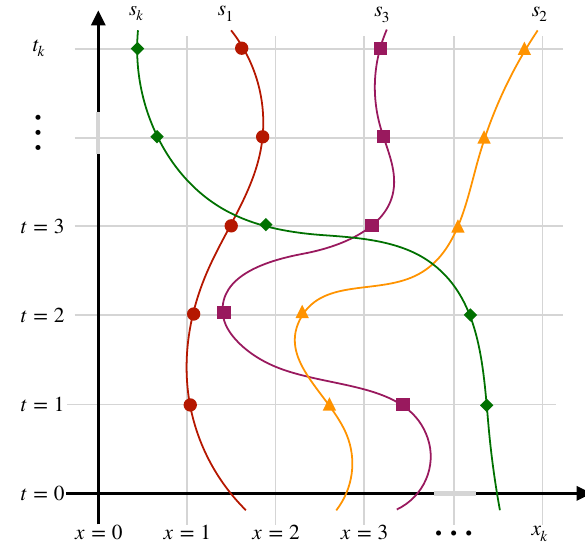
FIG. 5. Continuous process. A stochastic process is a joint probability distribution over all times. From a physical perspec- tive, we can think of it as the probability of observing a trajectory s k . This is highly desirable when talking about the motion of a Brownian particle. However, this interpretation requires some caution as there are cases where trajectories may not be smooth or even